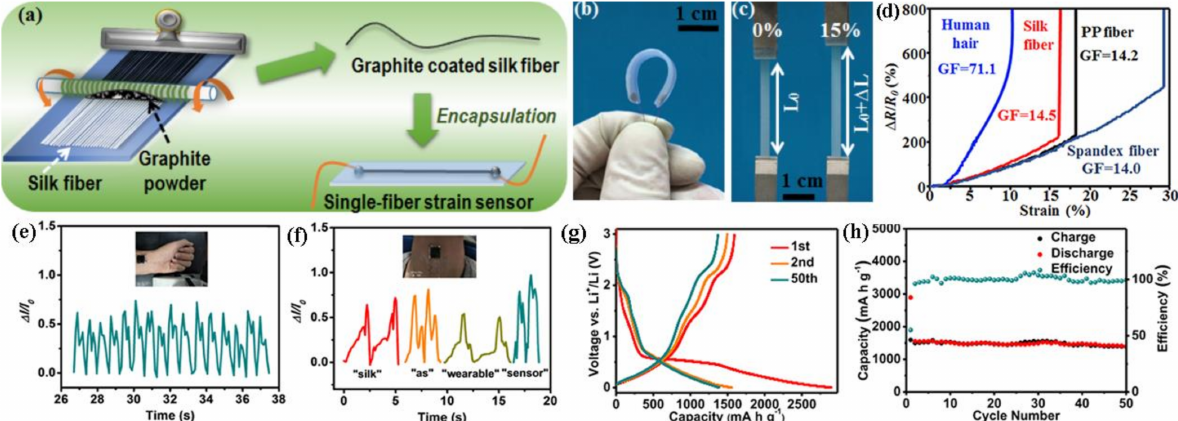
Figure 5. ( a ) Fabrication of sheath-core structured graphite/silk strain sensors through a dry-Meyer-rod-coating process, ( b ) photograph of the flexible strain sensor, ( c ) photograph of the strain sensor subjected to strain of 0% and 15%, ( d ) compar- ison of the sensitivity and elongation of sheath-core graphite/fiber strain sensors with different core fibers, including hair, silk, polypropylene (PP), and Spandex fibers. Reproduced with permission from [60]. Copyright 2016, American Chemical Society; ( e ) the response of the MoS 2 /CSFs sensor for monitoring healthy adults’ wrist pulse, ( f ) the response curves for the sound signal when the volunteer spoke “silk” “as” “wearable” “sensor”, ( g , h ) electrochemical properties of MoS 2 /CSFs as the anode in Li-ion batteries. Reproduced with permission from [61]. Copyright 2020, American Chemical Society.